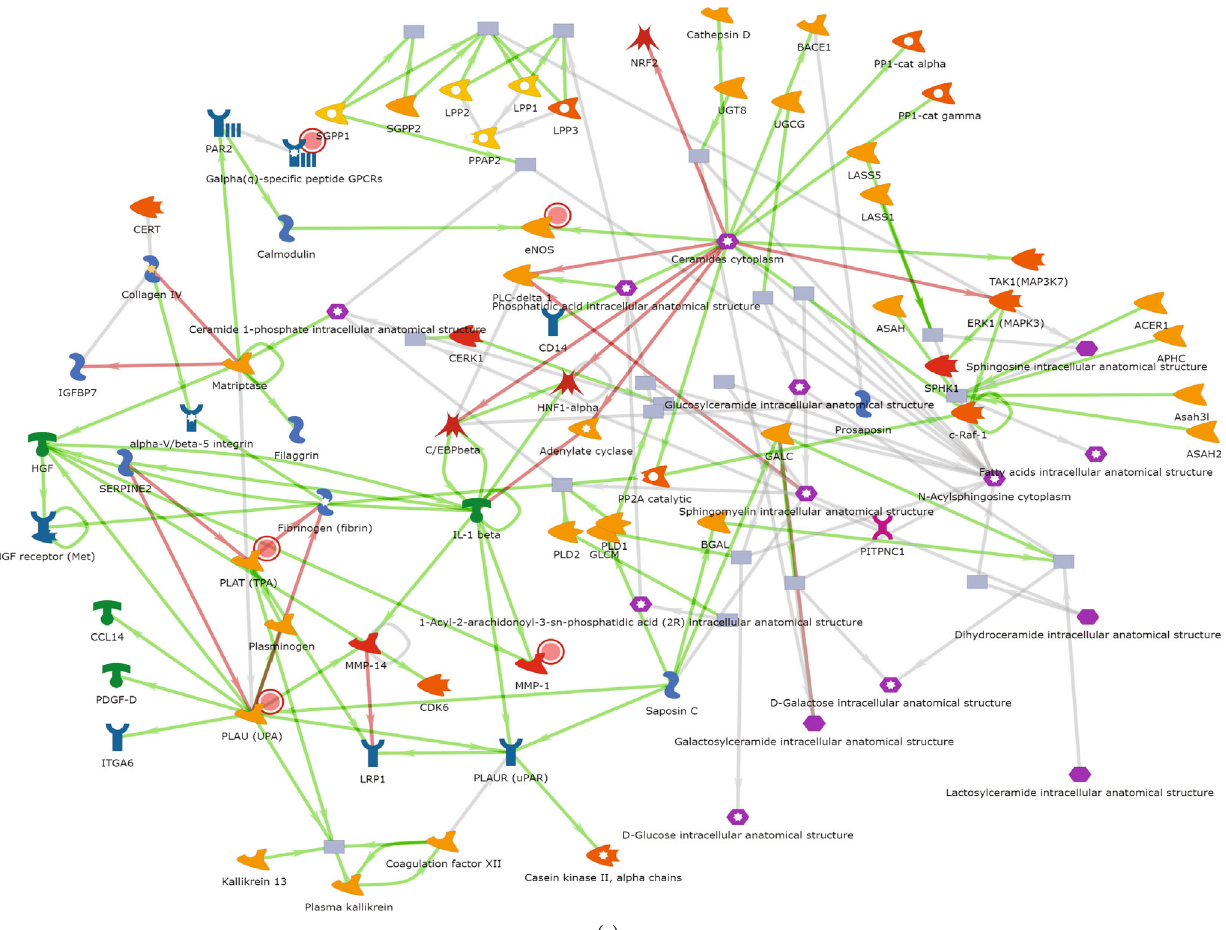
Figure 3: Overexpressed pathways shared by the two in vitro monkeypox-infected models. (a) The top 5% of overexpressed genes shared by the GSE21001 and GSE36854 datasets, fi ltered by a Venn diagram, represent the monkeypox-infected Macaca mulatta kidney epithelial (MK2) cell model and the human immortal epithelial cancer (HeLa) cell model. (b) The most enriched biological pathways corresponding to genes from the shortlist of upregulated genes shared by the two models, in order of decreasing log ( p values). (c) The most enriched metabolic pathways as components of the Endogenous Metabolic Networks corresponding to genes from the shortlist of upregulated genes shared by the two models, in order of decreasing log ( p values). (d) Related pathways and network analyses by MetaCore con fi rmed the vital role of the “ immune response_IL-1 signaling ” pathway in both monkeypox-infected models. (e) Endogenous Metabolic Networks analyses by MetaCore con fi rmed the vital role of the “ N-acyl-sphingosine phosphate pathway ” in both monkeypox-infected